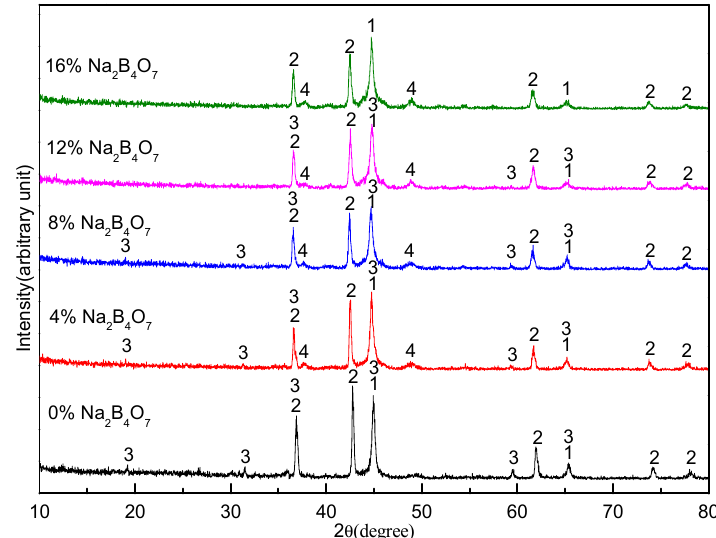
Figure 3. XRD patterns of the pellets with different sodium borate dosage reduced at 1300 °C for 90 min . 1—Fe(PDF#06 ‐ 0696); 2—TiN(PDF#38 ‐ 1420); 3—MgAl 2 O 4 (PDF#21 ‐ 1153); 4—Fe 3 C(PDF#76 ‐ 1877).